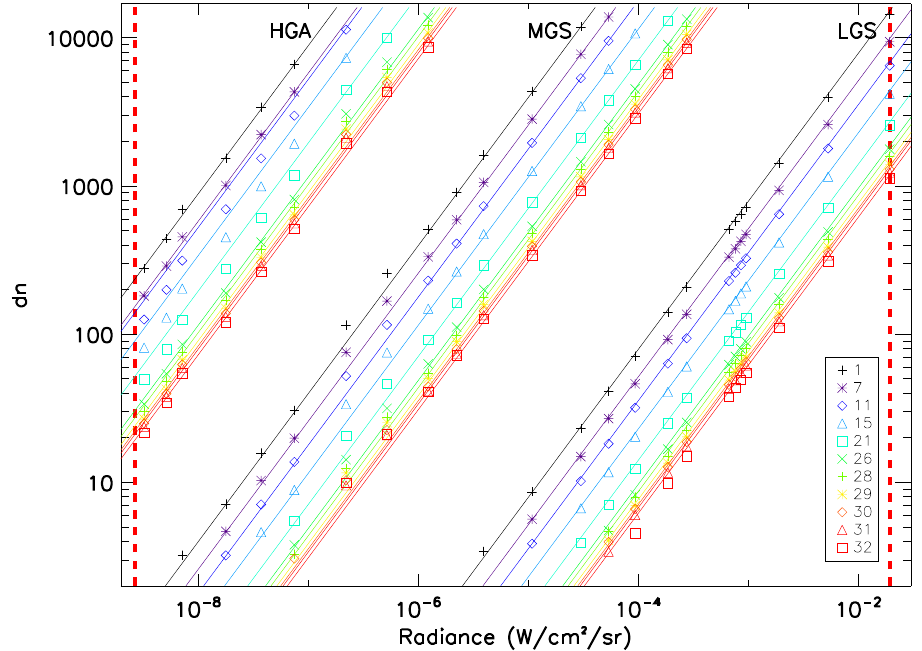
Figure 2. JPSS-3 VIIRS DNB response versus radiance for select aggregation